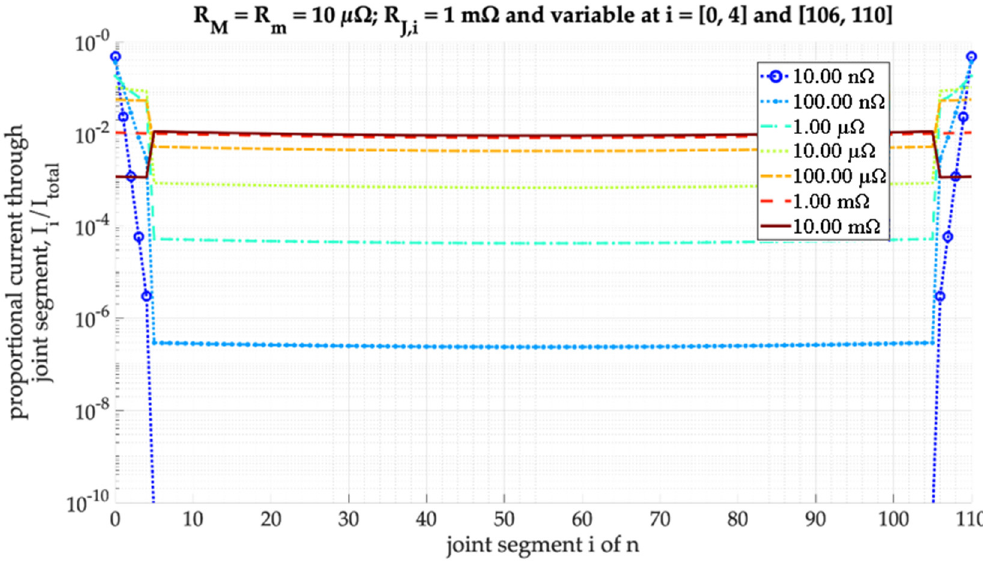
Figure 5. Simulation of current through a simplified model with weld seams on the joint’s edges.